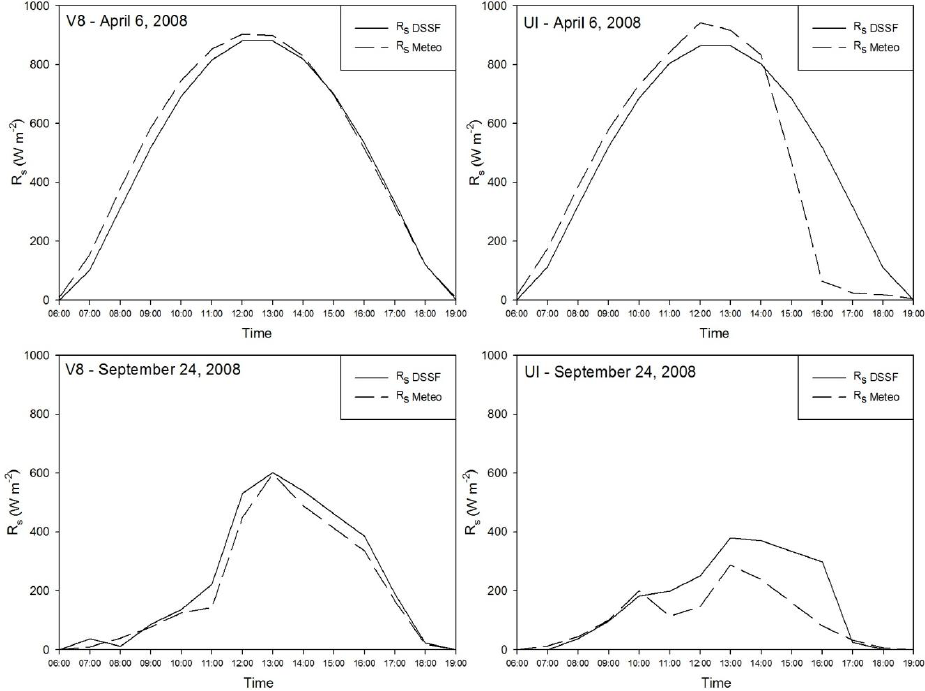
Fig. 3. Examples of daily solar radiation cycle from dawn to dusk at two meteorological stations located in flat conditions (V8) and hilly Figure 3. Examples of daily solar radiation cycle from dawn to dusk at two 2 conditions (UI) during a clear sky day (6 April 2008) and cloudy sky day (24 September 2008). Time in meteorological stations located in flat conditions (V8) and hilly conditions (UI) during a 3 clear sky day (April 6, 2008) and cloudy sky day (September 24, 2008). Time in UTC. 4